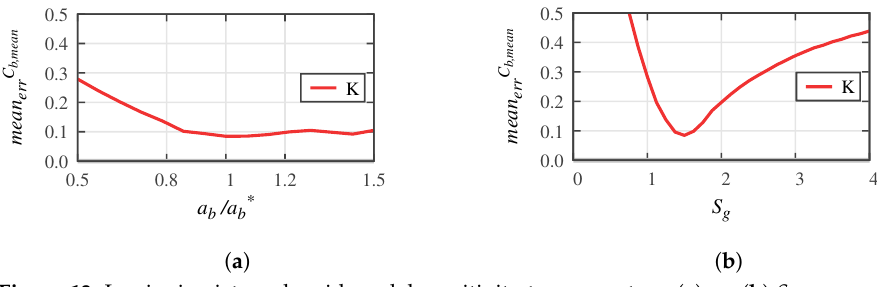
Figure 13. Impinging jet—sub-grid model sensitivity to parameters: ( a ) a b . ( b ) S g